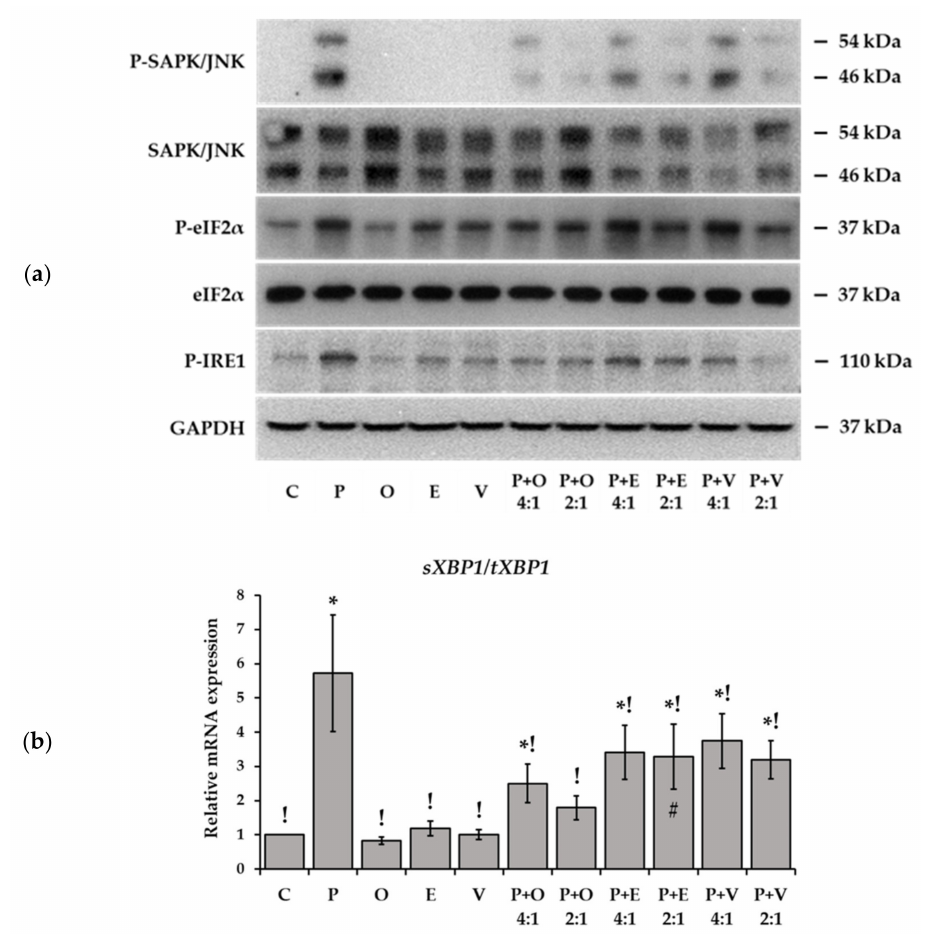
Figure 8. Protein and mRNA markers of ER stress. Cells were treated with BSA-conjugated palmitate, oleate, elaidate or vaccenate (800 µ M) or with palmitate (800 µ M) and oleate, elaidate or vaccenate at a 4:1 or 2:1 molar ratio (200 or 400 µ M) at 70–80% confluence for 8 h. ( a ) Phosphorylated and total SAPK/JNK isoforms (P-JNK 1/2), phosphorylated and total eIF2 α (P-eIF2 α ) and phosphorylated IRE1 proteins were detected by Western blot in the cell lysates. GAPDH was used as a constitutive parallels. ( b ) cDNA was prepared and spliced sXBP1 and total tXBP1 were detected by qPCR.